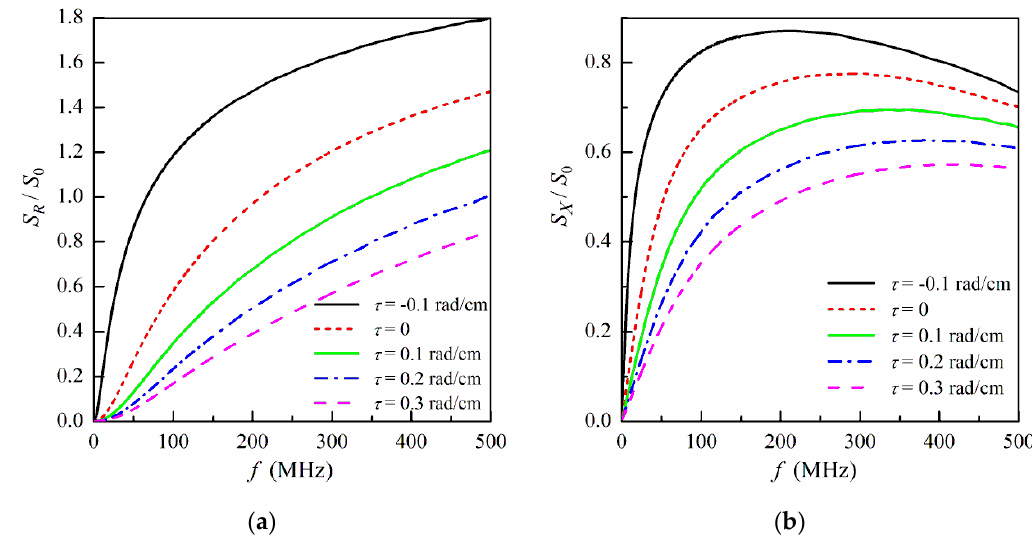
Figure 10. The field sensitivity of the real part S R ( a ) and imaginary part S X ( b ) of the ODMI as a function of the frequency f at I b = 30 mA for different values of the angular displacement per unit length τ . Magnetostriction coefficient λ s = 40 × 10 − 6 , shear modulus G = 50 GPa, other parameters used for calculations are the same as in Figure 3.